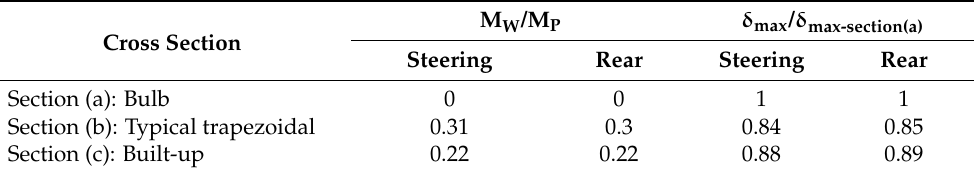
Figure 13. Orthotropic steel deck local axes of trapezoidal section. Table 1. Frame Analysis Comparisons.